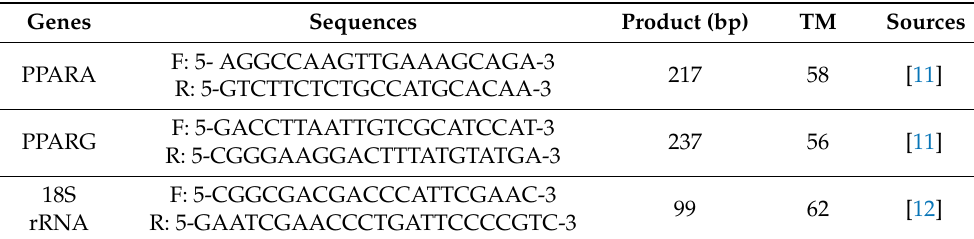
Table 1. Primer sequence, PCR product size, and annealing